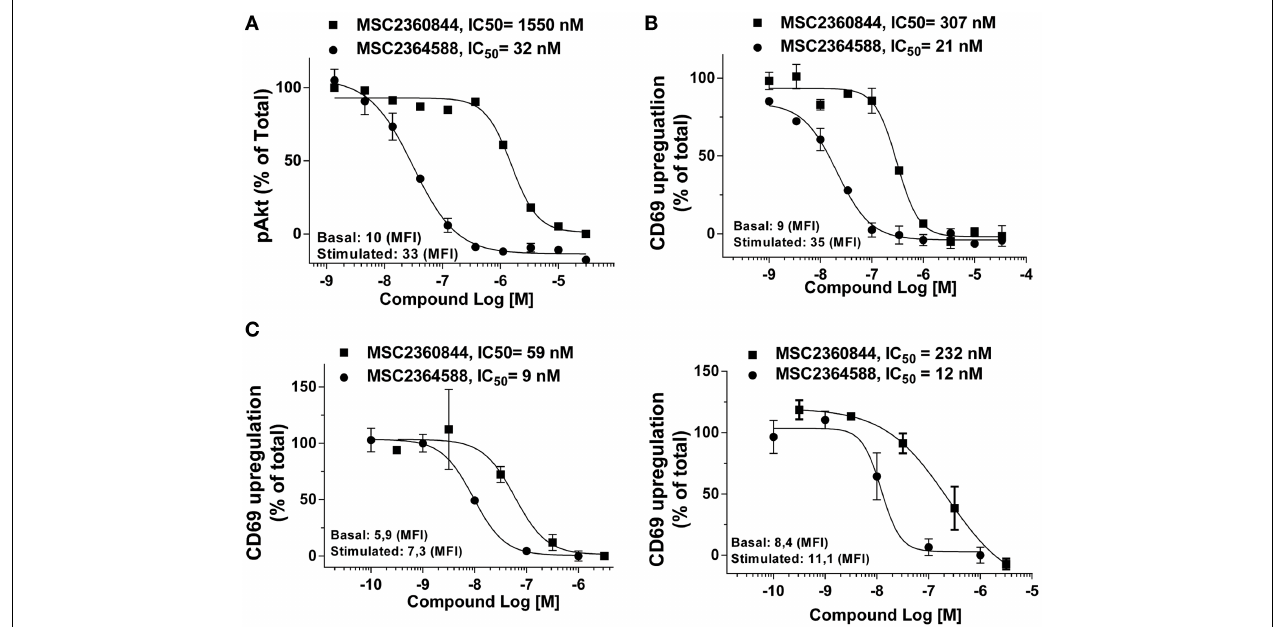
fluorescent intensity (MFI) from basal and stimulated conditions without inhibitor were used as 100% of activity. Data shown are mean ± SEM and are representative for at least five healthy donors. (C) PBMCs from two SLE patients were stimulated with anti-IgM for 18h. CD69 up-regulation on CD19 + cells were analyzed by flow cytometry. Mean fluorescent intensity (MFI) from basal and stimulated conditions without inhibitor were used as 100% of